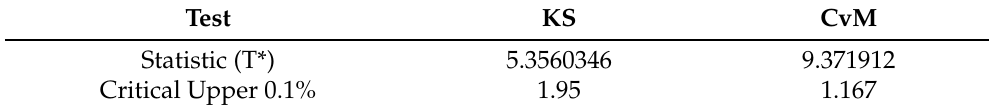
Table 5. Goodness-of-fit statistics based on the EDF.